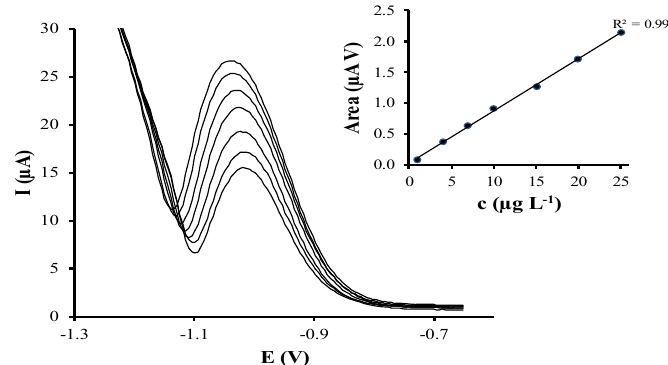
Figure 4. DPASV voltammograms of As(V) and its calibration plot (top-right inset) in 0.01 mol L − 1 HCl pH 2 applying an E d of − 1.30 V and a t d of 120 s using a Ag ‐ NS ‐ SPCNFE.